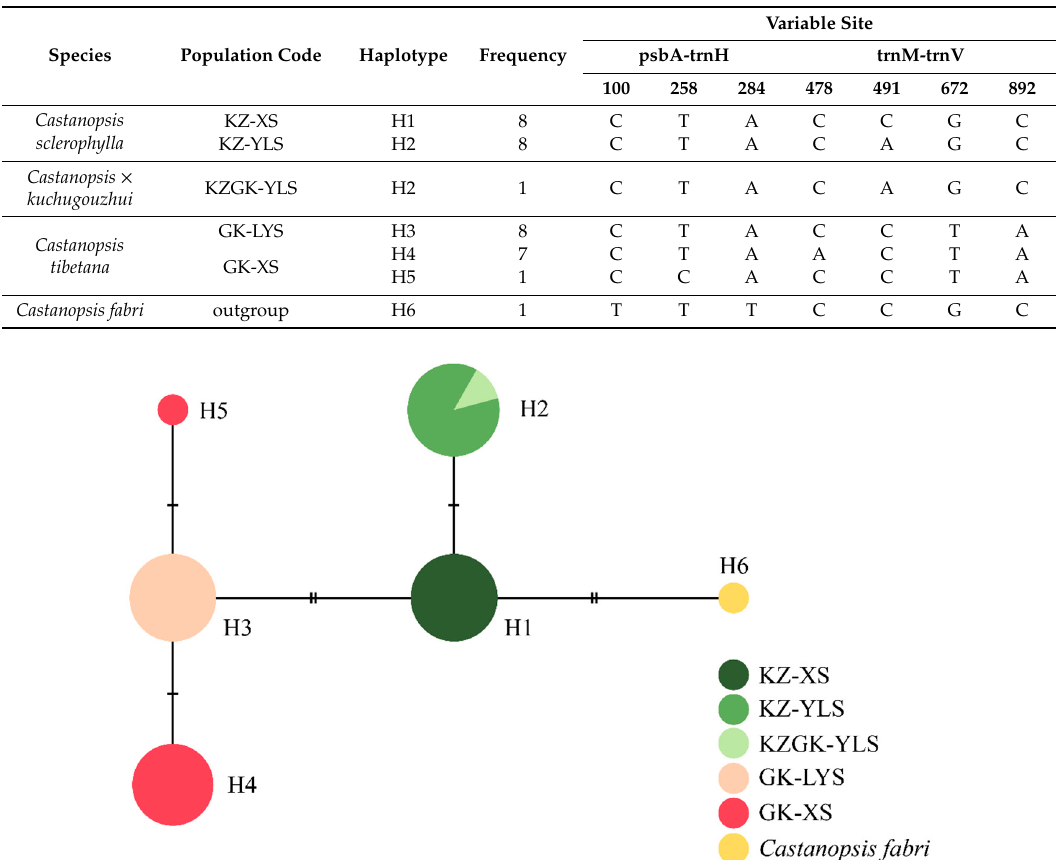
Figure 1. Haplotype relationships shown on median-joining network. The size of each circle is proportional to the haplotype frequency. Mutational steps between the haplotypes are indicated on the line. Population codes are the same as in Table 1.